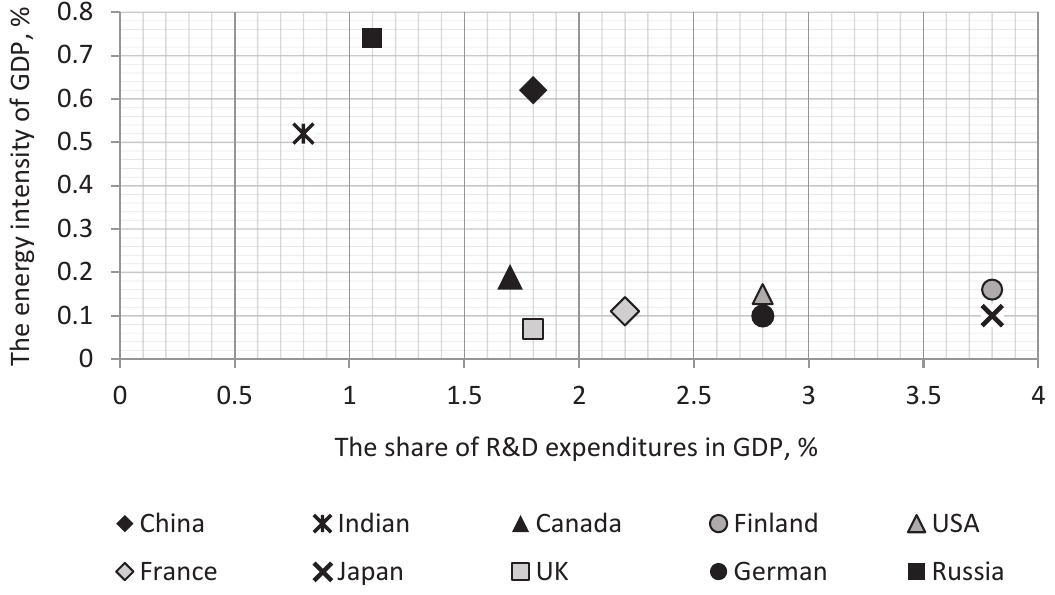
Figure 4. The correlation share of R&D expenditures in GDP and the energy intensity of GDP in different